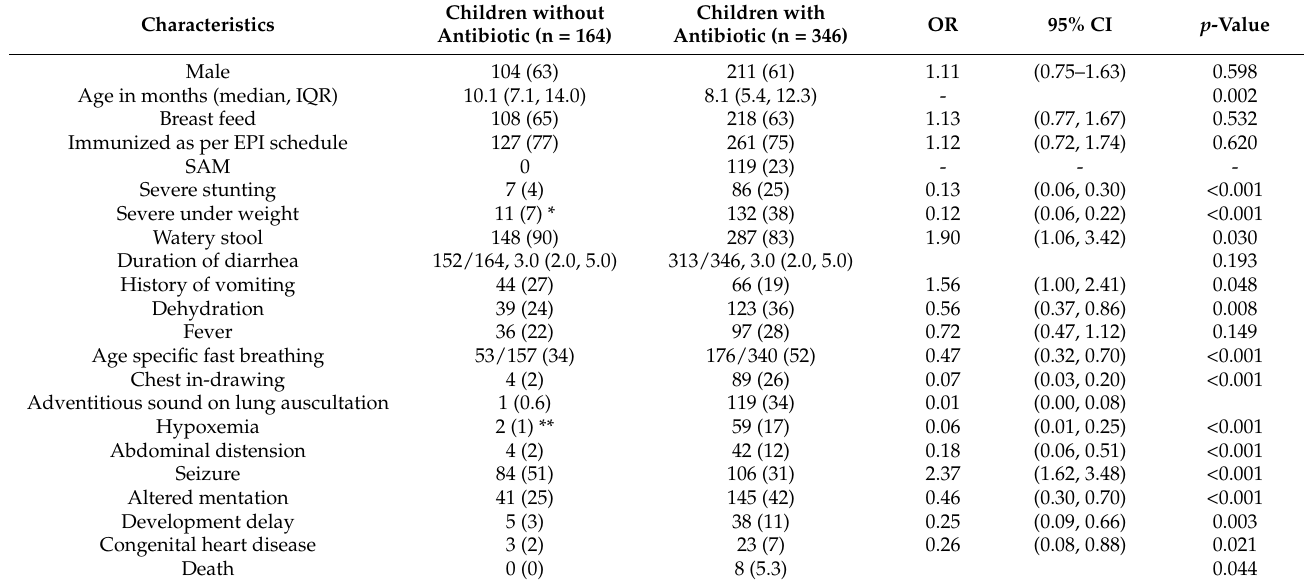
Table 1. Sociodemographic and clinical characteristics of critically ill ICU children aged below five years without (cases) and with antibiotic therapy (controls) in Bangladesh.